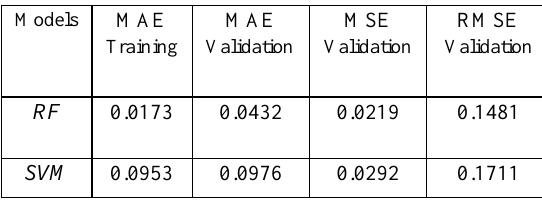
Table 2 . Error rates of RF and SVM models in the process of training and